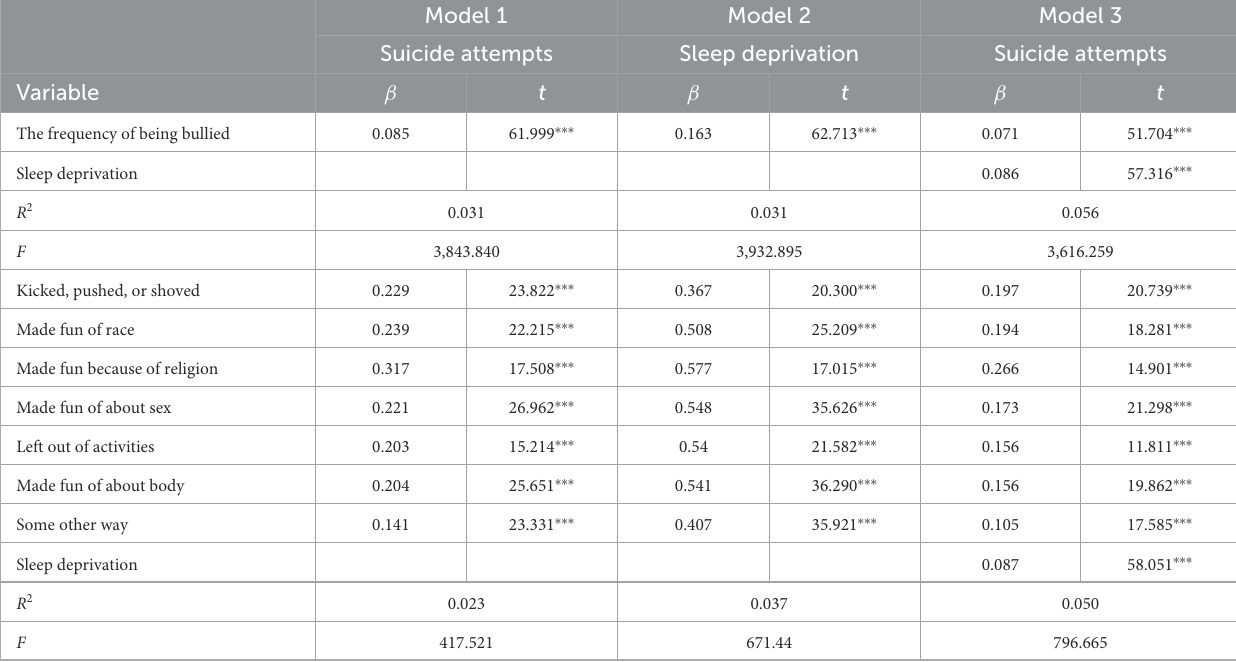
TABLE 2 The mediating effect of sleep deprivation as a dependent variable ( n = 121,869).